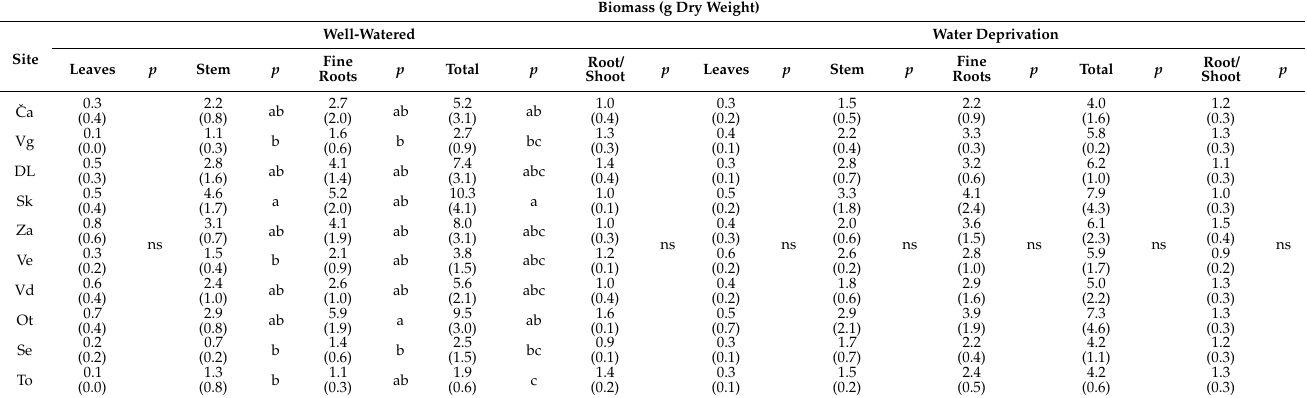
Table 3. Dry biomass of saplings originating from 10 forest stands in Croatia. The weights (g) of dry biomass (48 h, 60 ◦ C) constitute mean values + S.D.s of four replicates in the well-watered treatment (harvested before water deprivation) and five replicates in the drought treatment (harvested after 29 days of drought exposure). p = results of one-way ANOVA for the well-watered or drought treatments between ecotypes ( p < 0.01). Different minor letters represent statistically significant differences between ecotypes at p < 0.01. Beech ecotypes are organized according to decreasing total